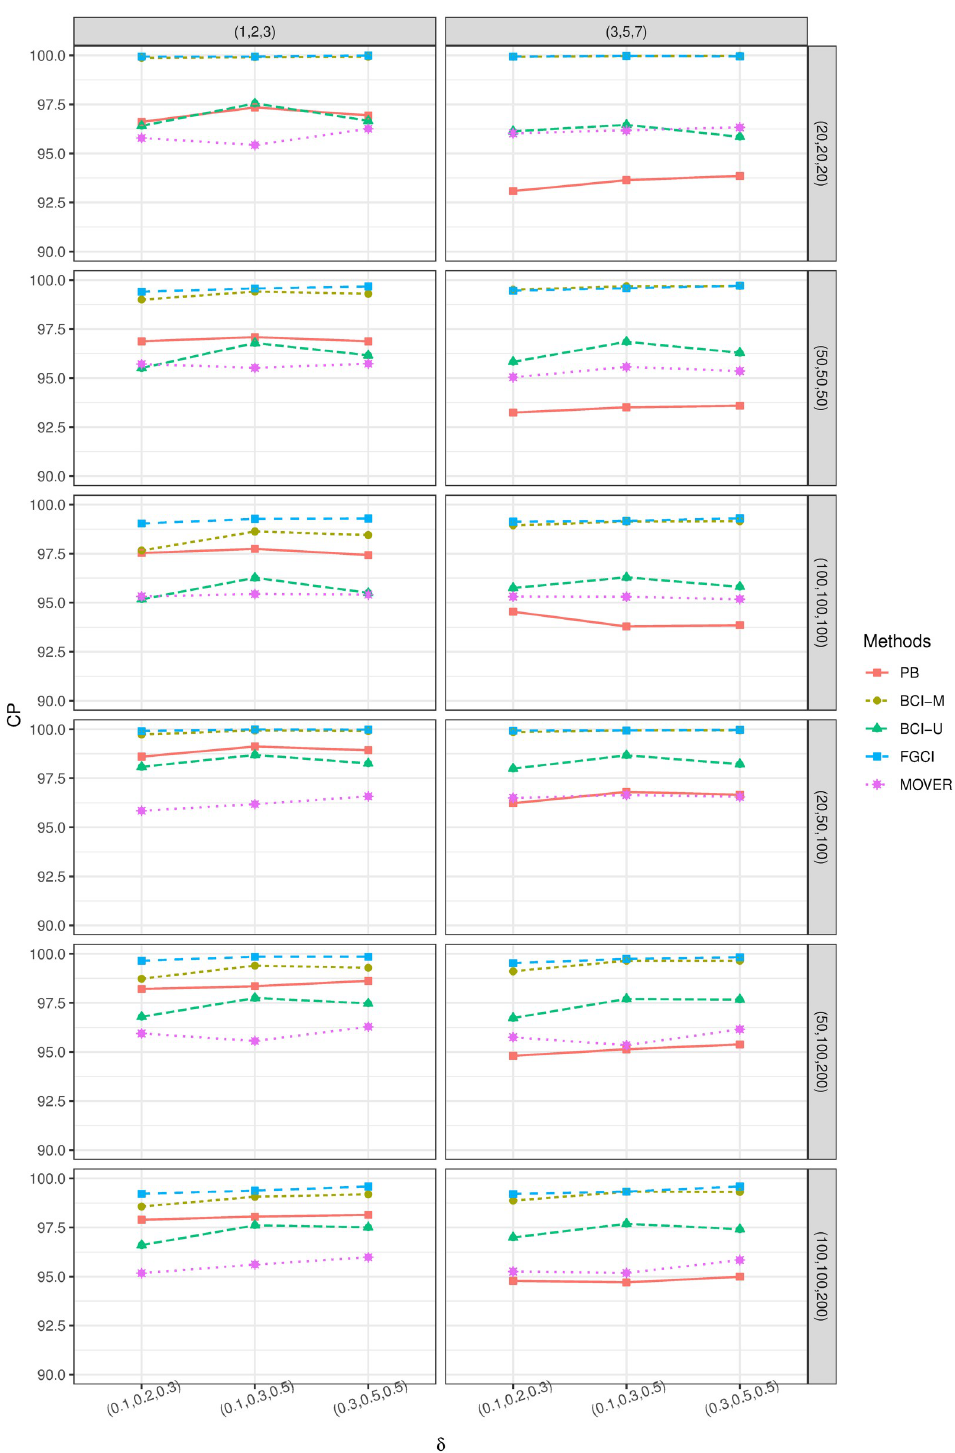
Fig 1. CP performances of 95%SCIs for θ jl : 3 sample